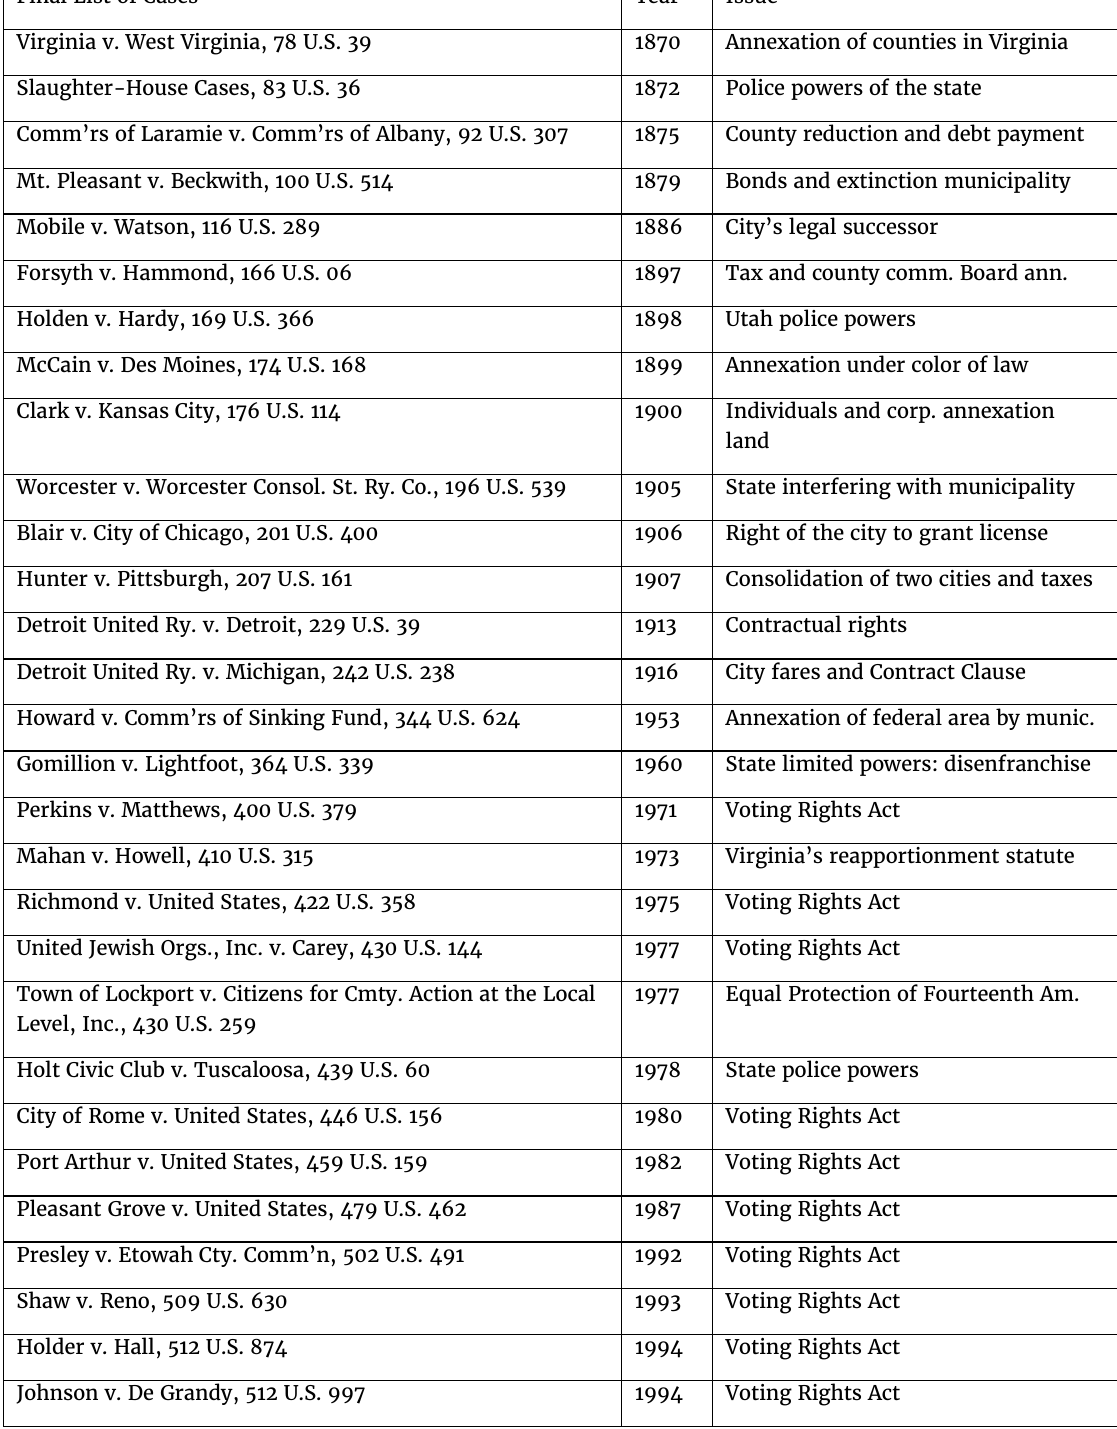
Table 1: Final List of Annexation Cases by the